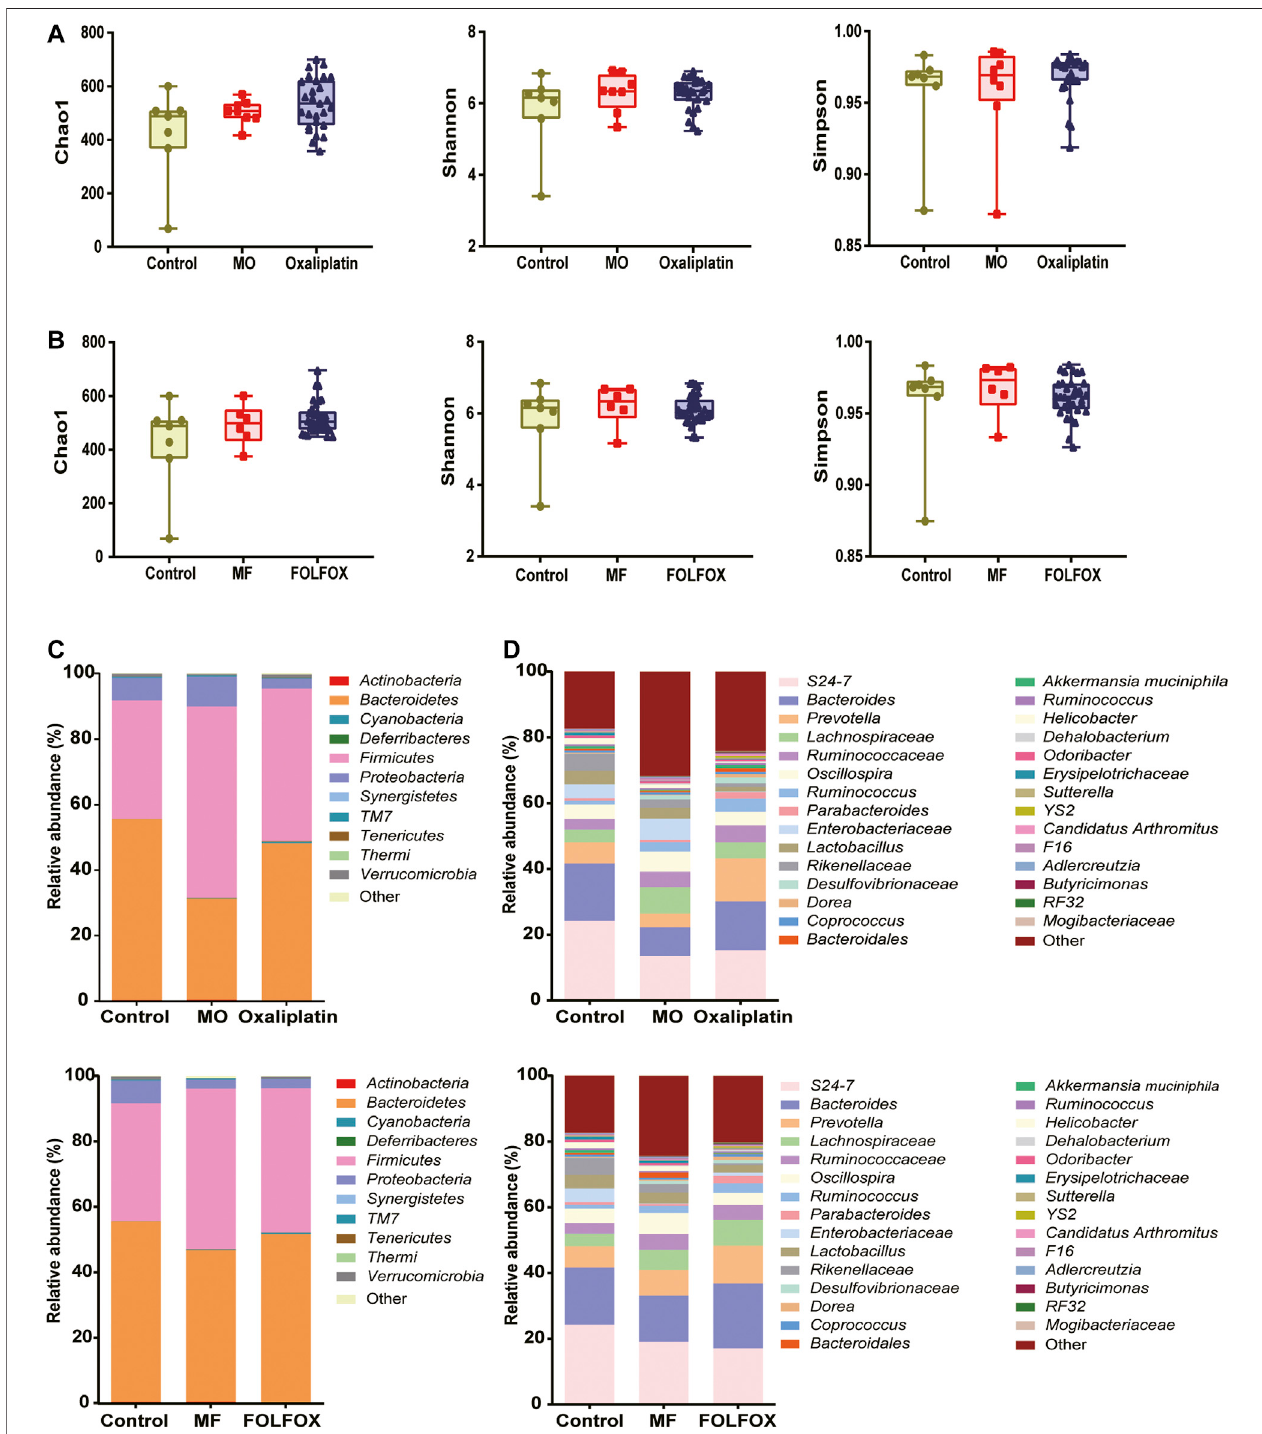
FIGURE2| Oxaliplatin and FOLFOX could reverse the disordered distribution ofgutmicrobiota inducedby tumor. (A, B) Change of α -Diversity estimated by Chao 1, Shannon and Simpson estimator. Taxonomic distributions of bacteria based on fecal 16S rDNA gene sequencing data at (C) phylum and (D) genus level after oxaliplatin or FOLFOX